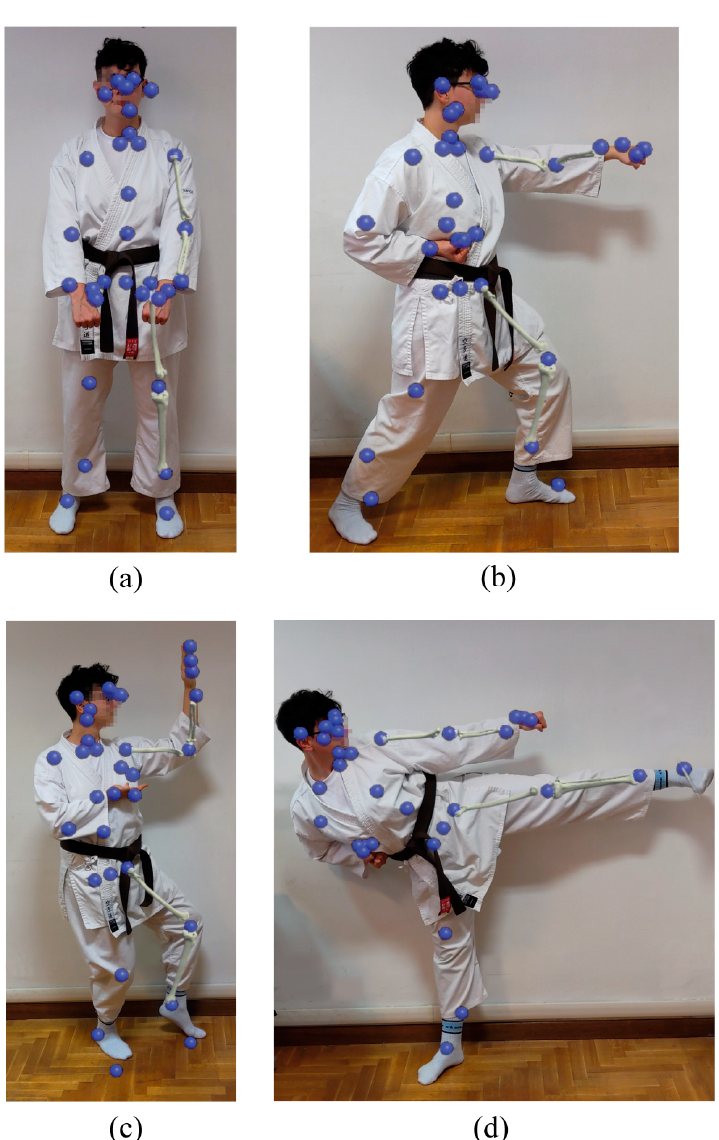
Figure 5. Karateka doing shots and stance and 3D holographic skeleton reproduced in HL2 glasses to evaluate the system performance: ( a ) Heiko Dachi (parallel stance) stance; ( b ) Juntzuki (lunge punch) on Zenkutsu Dachi (forward leaning stance) stance; ( c ) Shuto Uke (knife hand block) on Shomen Neko Aishi Dachi (front facing cat leg stance) stance; ( d ) Sokuto Geri (lateral kick) chudan.